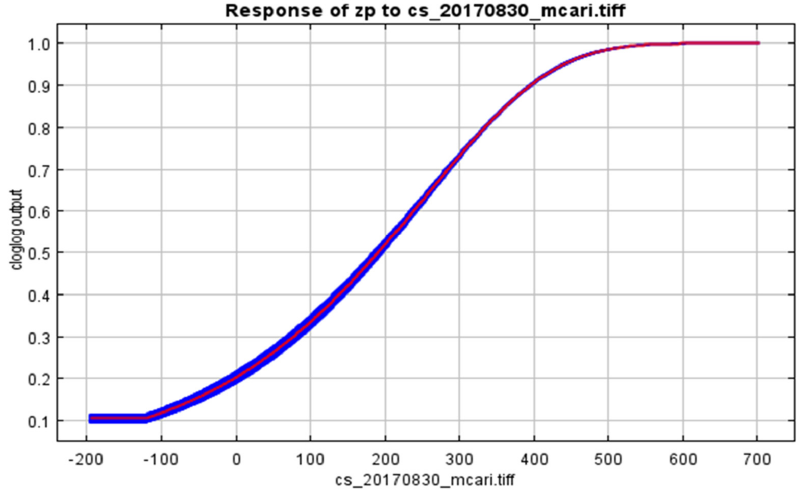
Figure 9. Dependence of probability of identifying waterlogged areas on the values of the MCARI index. Case 1—site 1, spring 2016, contribution to